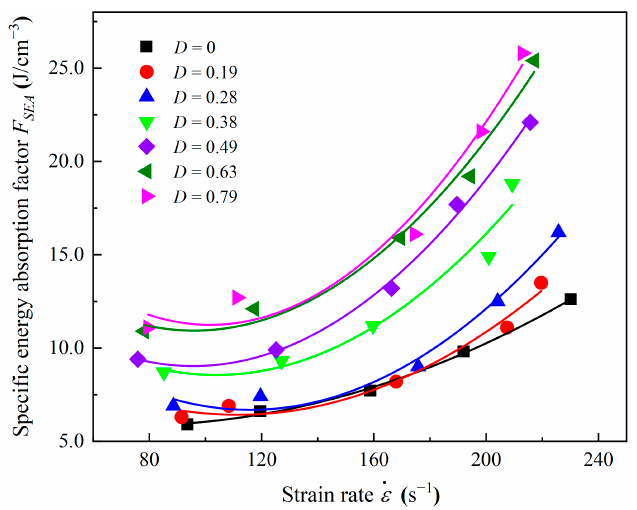
Figure 24. Specific energy absorption factors of sandstone.